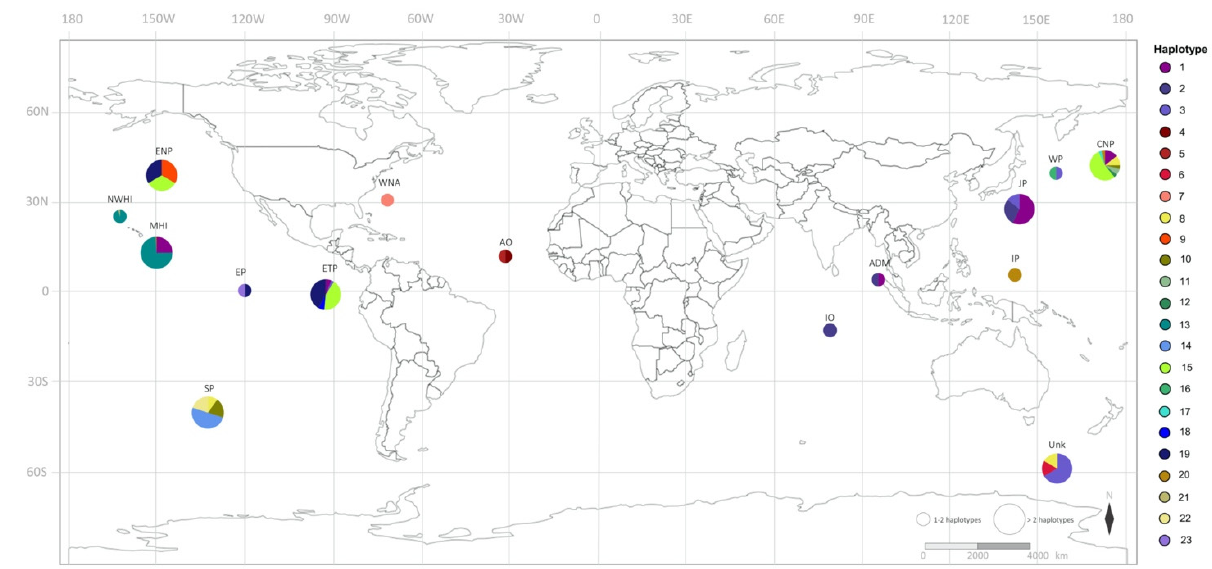
Figure 2. Map showing the geographic distribution of false killer whale mtDNA control region haplotypes. Each circle represents the haplotypes of false killer whales in each location. The two sizes of circles indicate the number of haplotypes: smaller, 1–2 haplotypes; larger, >2 haplotypes. The color indicating the haplotype and the proportion of color in each circle are related to haplotype frequency. Abbreviations for location are as follows: ADM, Thai Andaman Sea; CNP, Central North Pacific Ocean; ENP, Eastern North Pacific Ocean; EP, East Pacific Ocean; ETP, Eastern Tropical Pacific Ocean; IP, Indo Pacific Ocean; JP, Japan; MHI, Main Hawaiian Islands; NWHI, Northwestern Hawaiian Islands; SP, South Pacific Ocean; WP, West Pacific Ocean; IO, Indian Ocean; AO, Atlantic Ocean; WNA, West Northern Atlantic Ocean; Unk, Unknown.